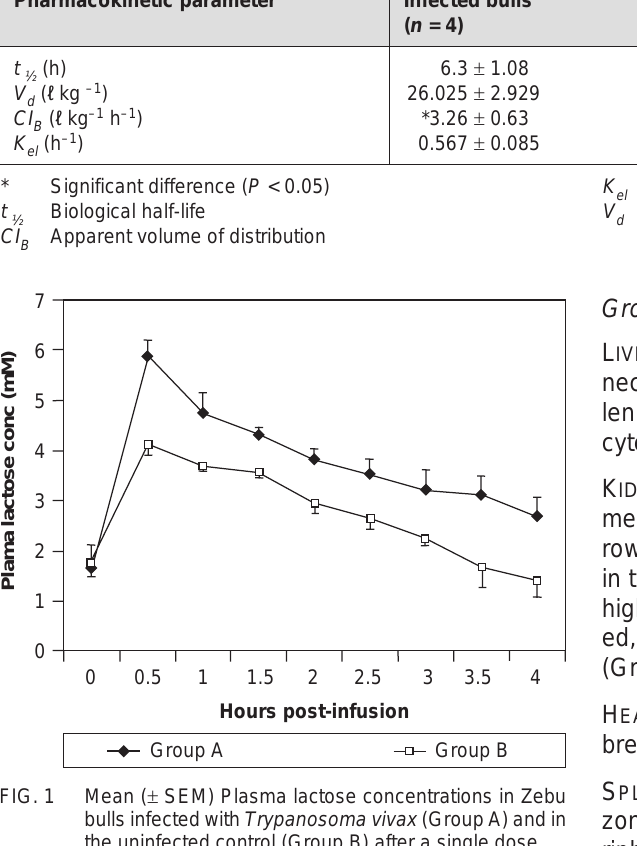
FIG. 1 Mean ( (cid:114) SEM) Plasma lactose concentrations in Zebu bulls infected with Trypanosoma vivax (Group A) and in the uninfected control (Group B) after a